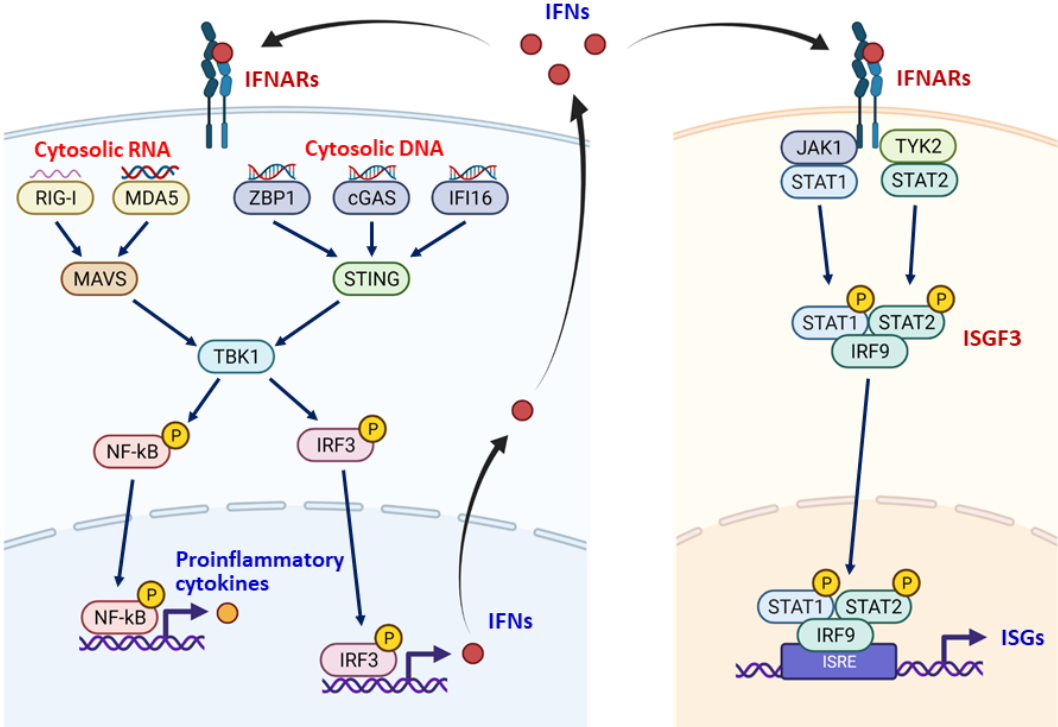
Figure 2. The interferon response. The type I interferons (IFNs, red dots) are induced by the detection of cytosolic DNA and RNA by various pattern-recognition receptors (ZBP1, cGAS, IFI16, RIG-I, MDA5), which then activate TBK1 through STING and MAVS (left part). The TBK1 phosphorylates IRF3 and NF-kB to activate their transactivation activities toward the promoters of IFNs and pro- inflammatory cytokine genes. The induced type I interferons are secreted outside of the cells to bind to their receptors (IFNARs) on the cell membranes of self and neighbor cells. The binding of IFNs to IFNARs activates JAK1 and TYK2 to phosphorylate STAT1 and STAT2, facilitating the formation of interferon-stimulated gene factor 3 (ISGF3) complex and subsequently transactivation of type II interferon and numerous interferon-stimulated genes (ISGs). The expressed IFNs, ISGs, and pro-inflammatory cytokines are critical for the induction of innate and adaptive immune responses. ISRE, interferon-stimulated response element. Graph created with Biorender.com. The induced type I interferons, which are secreted from virus infected or malignant cells, stimulate the expression of type II interferon (IFN- γ ) and numerous interferon- stimulated genes (ISGs) by binding to the type I interferon receptors (IFNAR1/IFNAR2) on the cell membrane. The interferon-bound IFNAR1/IFNAR2 activate the Janus kinase 1 (JAK1) and Tyrosine kinase 2 (TYK2), which phosphorylate the interferon-stimulated gene factor 3 (ISGF3) composed of interferon regulatory factor 9 (IRF9), signal transducer and activator of transcription 1 (STAT1), and STAT2 (Figure 2). Because almost all cells, especially immune cells, express IFNAR1/IFNAR2, type I interferons play a central